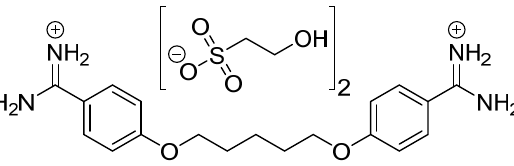
Figure 1. Chemical structure of pentamidine isethionate. Pentamidine is the active constituent and is